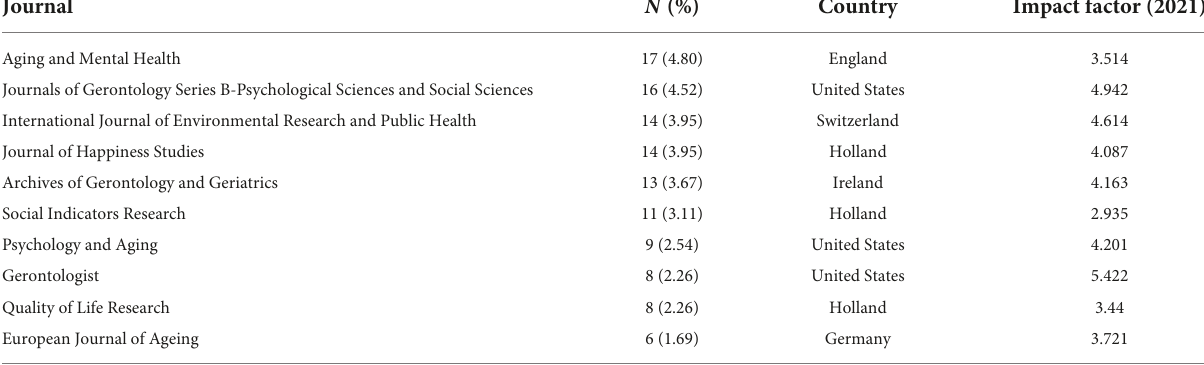
TABLE 1 Summary of the publications of the top 10